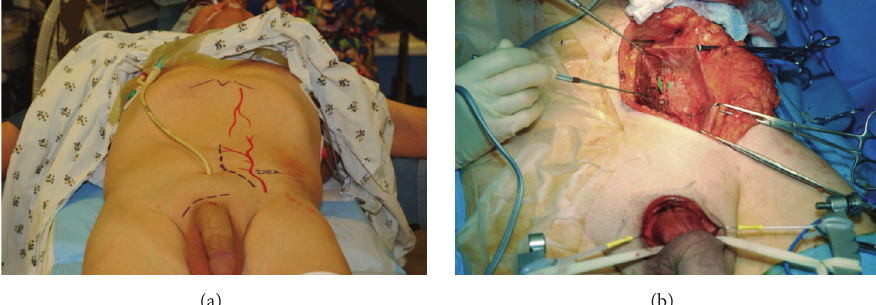
Figure 6: Inferior epigastric artery to dorsal artery penile revascularization, shown subsequent to skin marking (a) and during surgery (b).